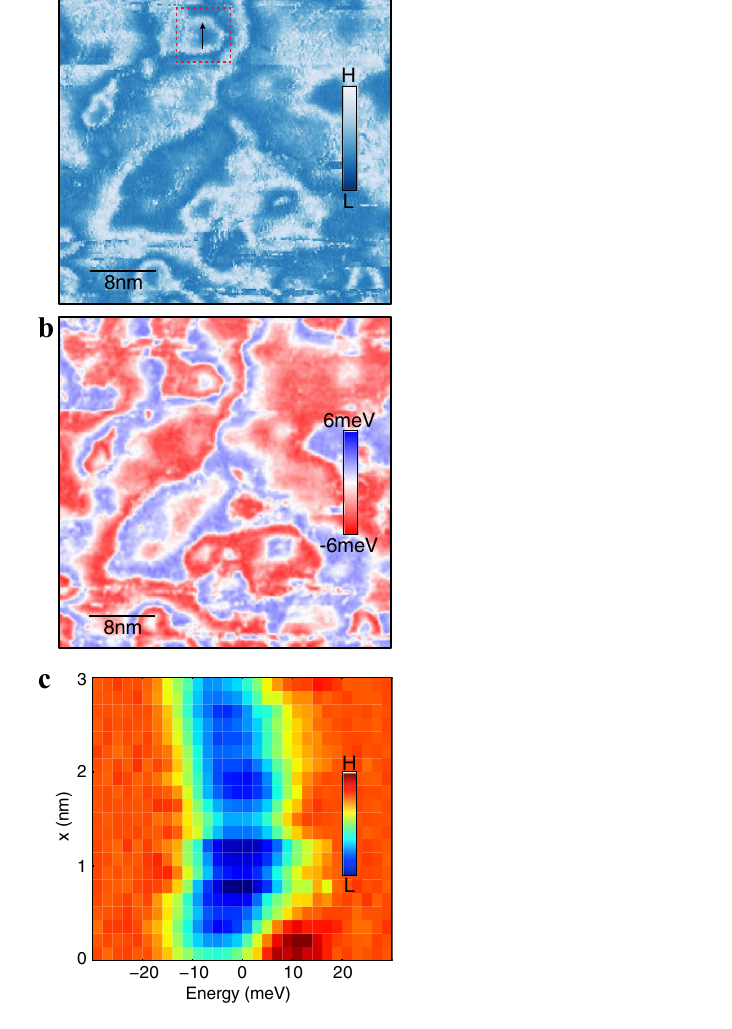
Figure 4. Energy offsets in a larger FOV. ( a ) g ( r , E = 4 meV) in a 40 nm × 40 nm FOV, taken at V bias = 150 mV and I = 150pA. ( b ) Energy offset map in the same FOV as a . Isolated “ring” features are seen in both differential conductance map and energy offset map. ( c ) Evolution of the spectra through the black vertical line in a plotted in a two-dimensional intensity plot. Colors represent the LDOS